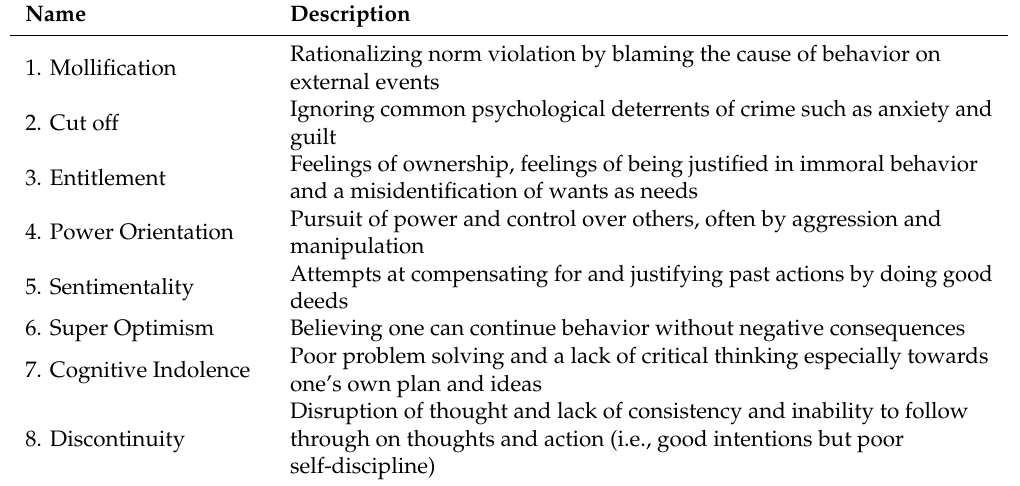
Table 1. Psychological Inventory of Criminal Thinking Styles (PICTS) subscales and descriptions (adapted from Walters, 1995)